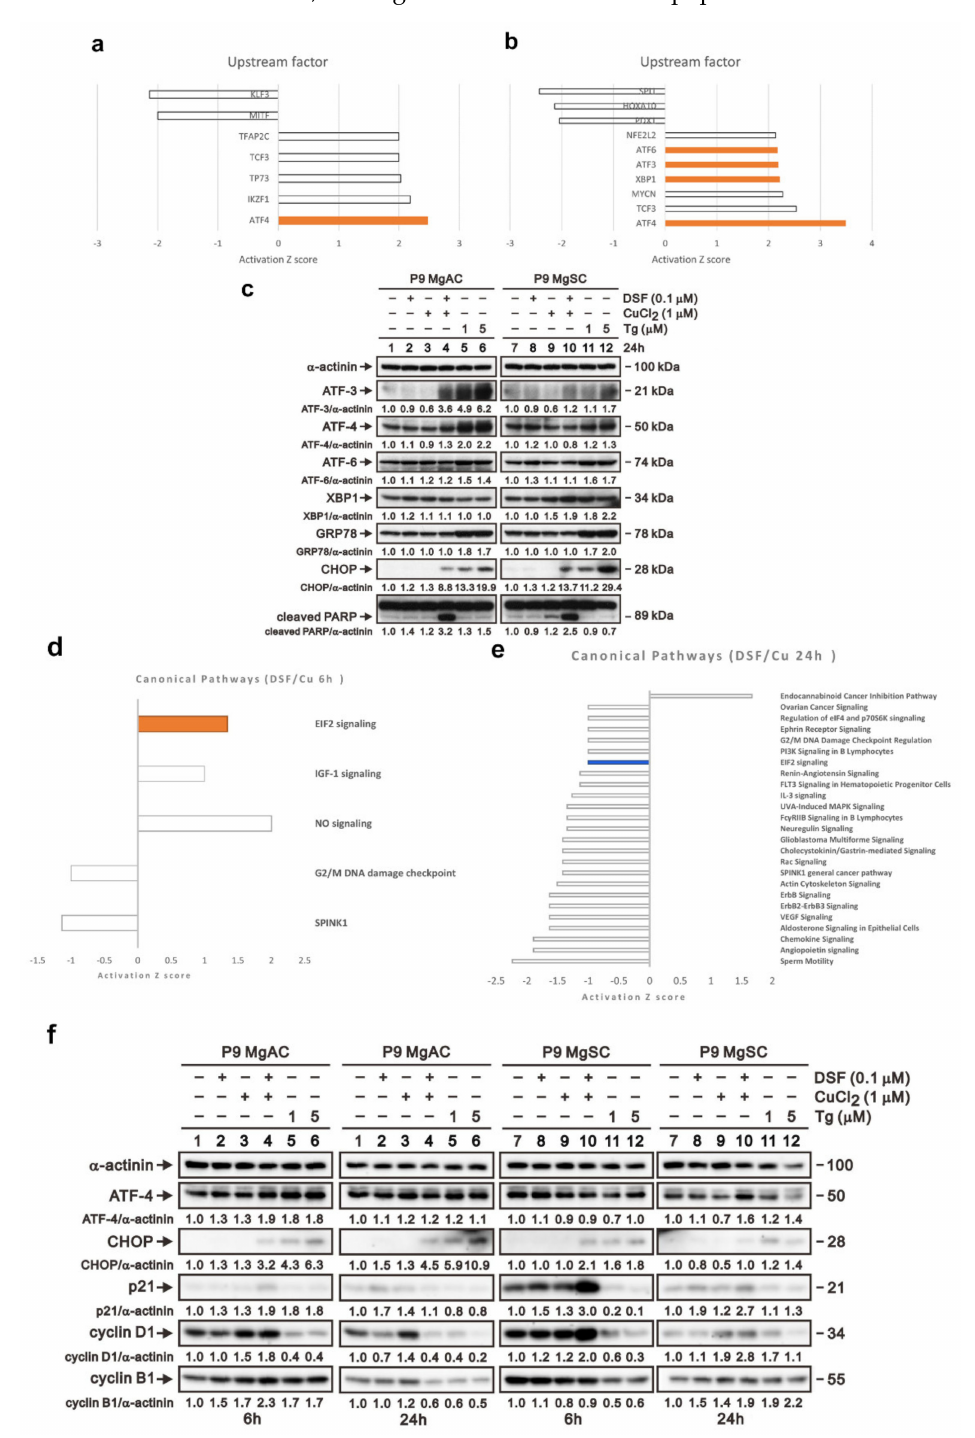
Figure 6. DSF/Cu induced ER stress in meningioma cells. The bar chart shows potential upstream regulators predicted with Ingenuity Pathway Analysis based on microarray data from MgACs treated for 6 h ( a ) or 24 h ( b ) with DSF and 1 µ M CuCl 2 . Shown are upstream regulators for which there was at least a 1.3-fold change in expression compared to vector control cells. ( c ) Cells were incubated for 24 h with 0.1 µ M DSF and 1 µ M CuCl 2 alone or in combination, after which expression of proteins related to the unfolded protein response was confirmed by Western blotting. Thapsigargin (Tg) is